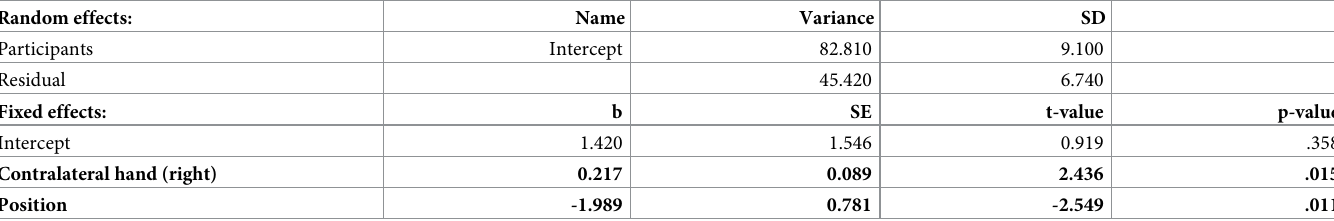
Table 5. Model 1.5. Effect of Position on the left grip force (after controlling for the contralateral force) in the time window 260–1000 ms (Experiment 1).